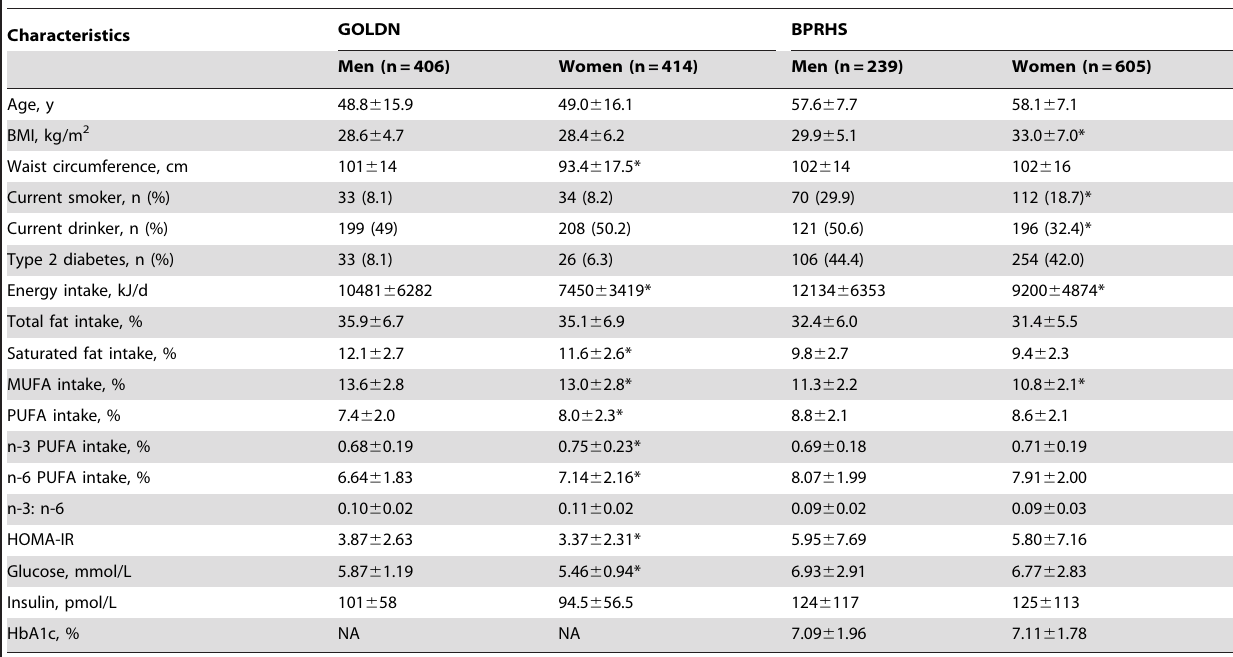
Table 1. Characteristics of participants in GOLDN and the BPRHS 1 .